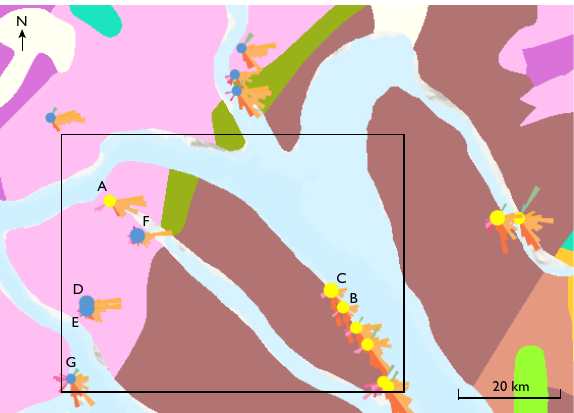
Fig. 2. Geological map (1:500 000) of Ymer Ø in the Kong Oscar Fjord area, East Greenland (output directly from the database; location marked in Fig.1). Locations of stream sediment (blue) and sandstone samples (yel- low) are marked, see Fig. 1 for further details. Inset: sampling locations of the seven samples ( A–G ; see Fig. 3) discussed in the text.